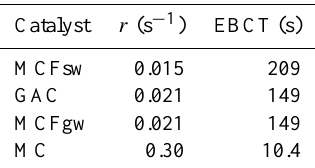
Table 2. EBCT of catalysts to decompose a peroxide concentration